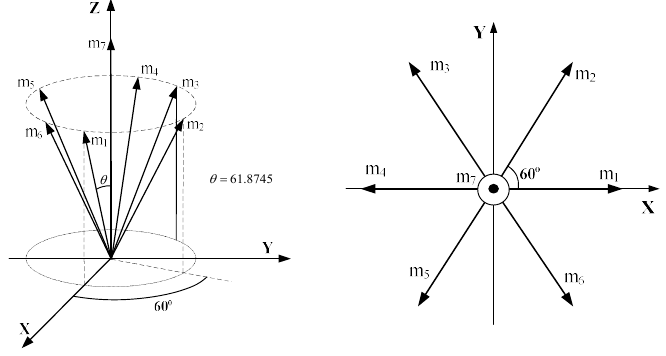
Figure 7. The redundant configuration of seven gyros.